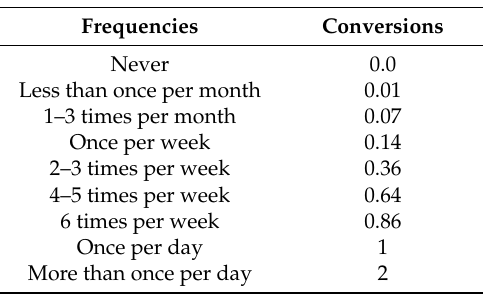
Table 2. Food frequency